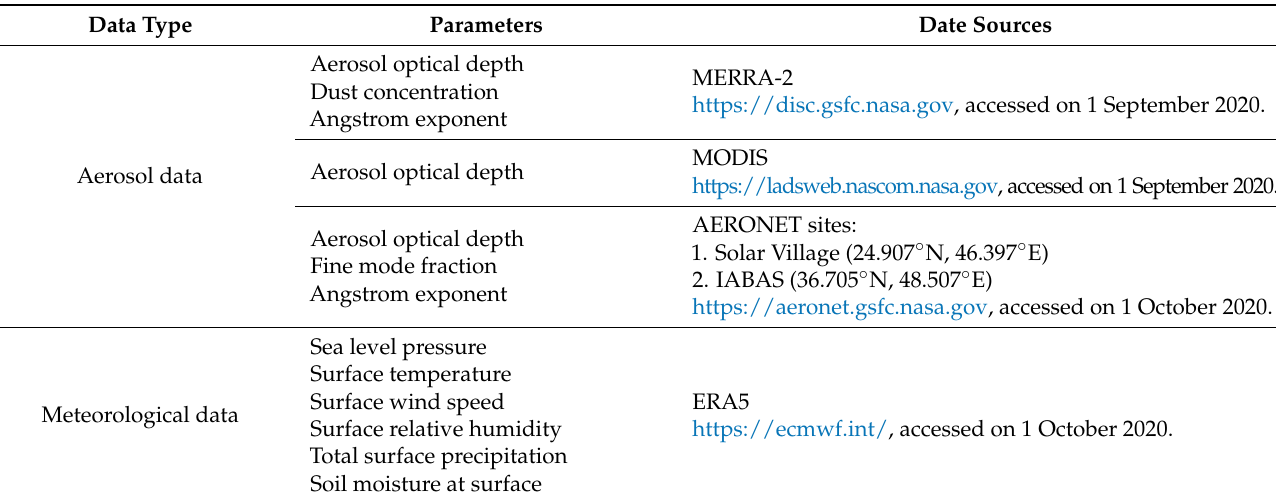
Table 1. Aerosol and meteorological data used in the present